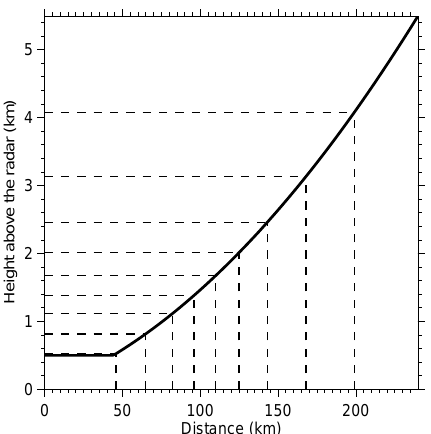
Figure 2. Measurement height as a function of distance for Swerad (thick, solid line). Thin, dashed lines show the range limits that were used to divide the Swerad data into 10 range rings with an